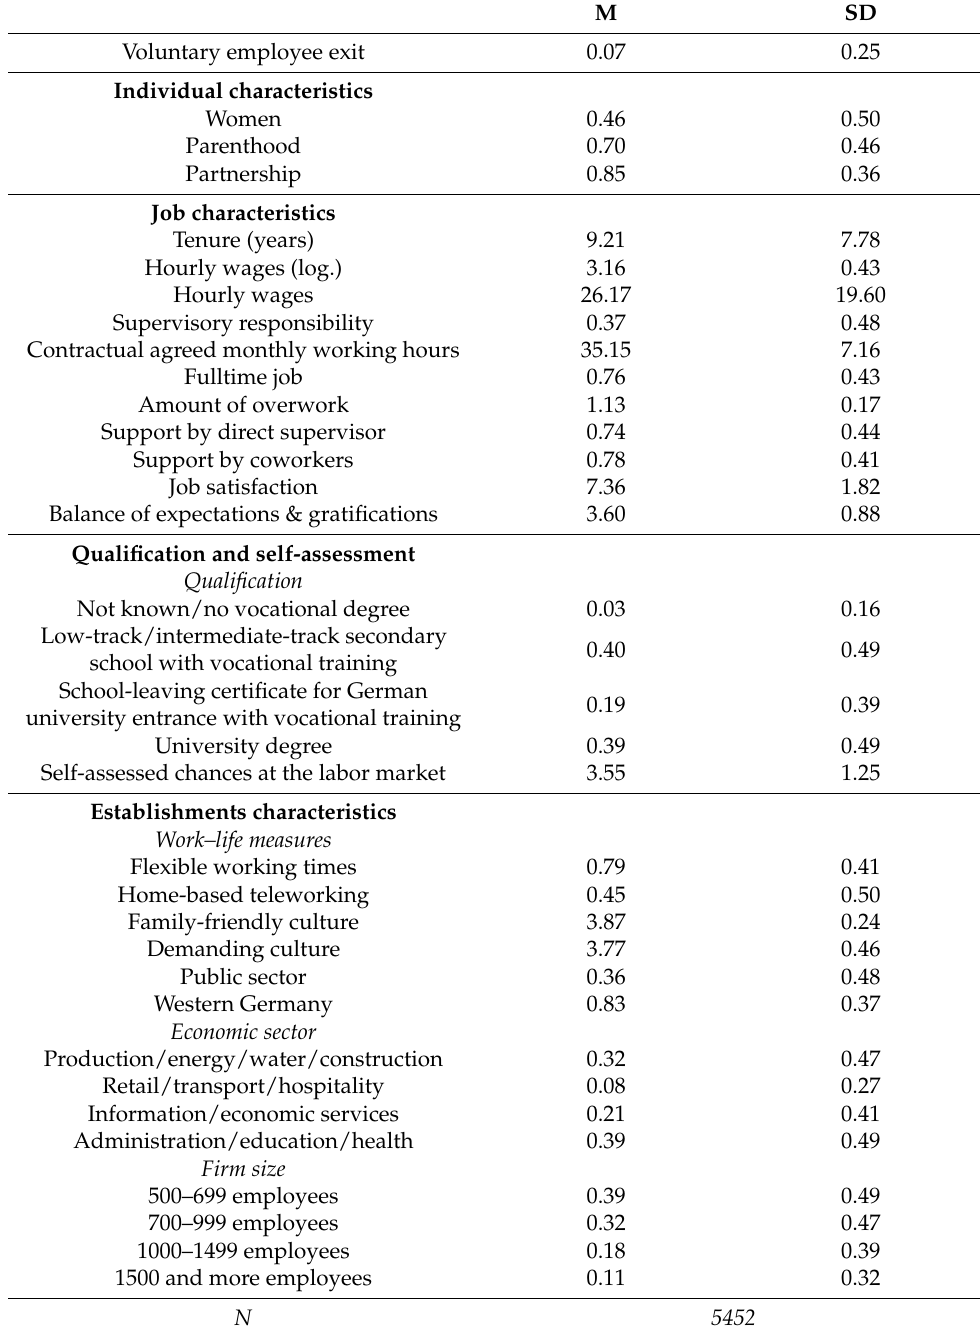
Table 1. Means and standard deviations of study